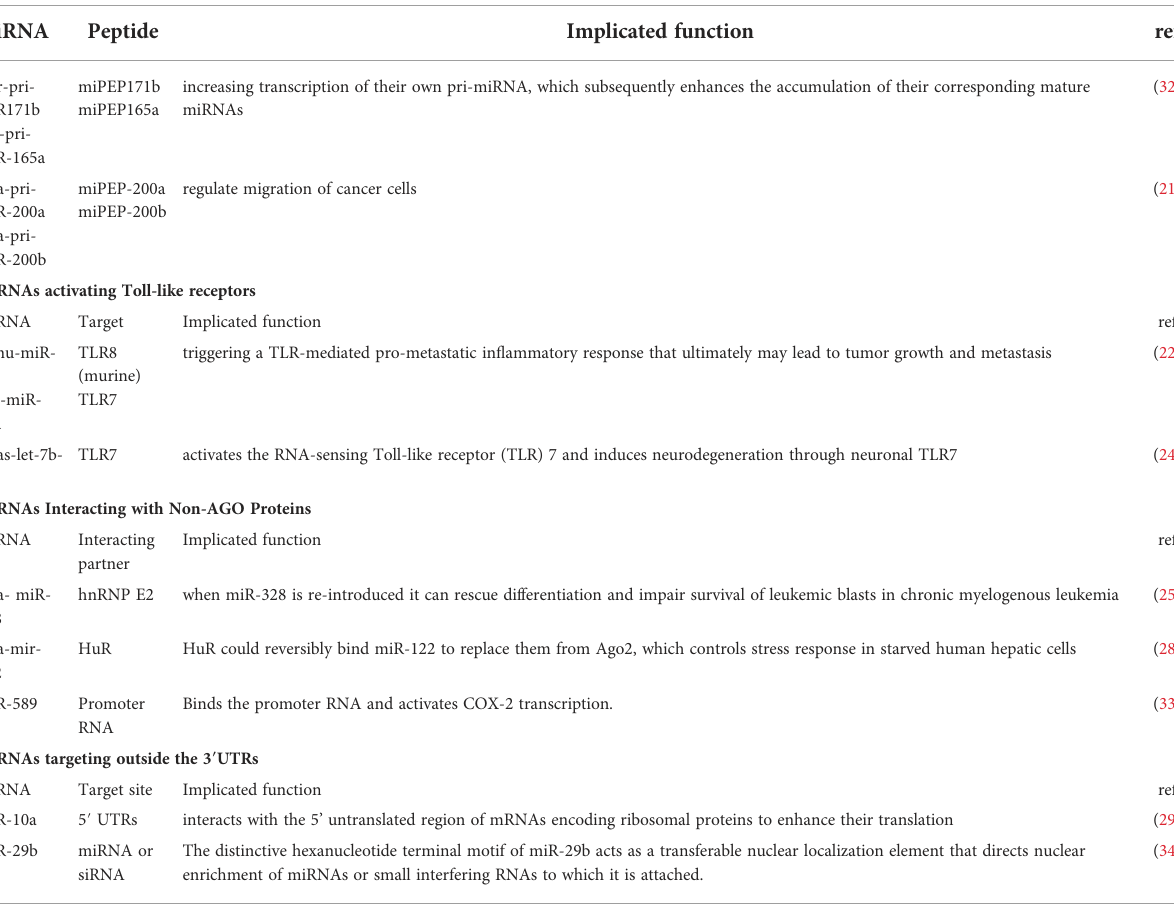
TABLE 1 Unconventional miRNA functions. Pri-miRNAs Coding for